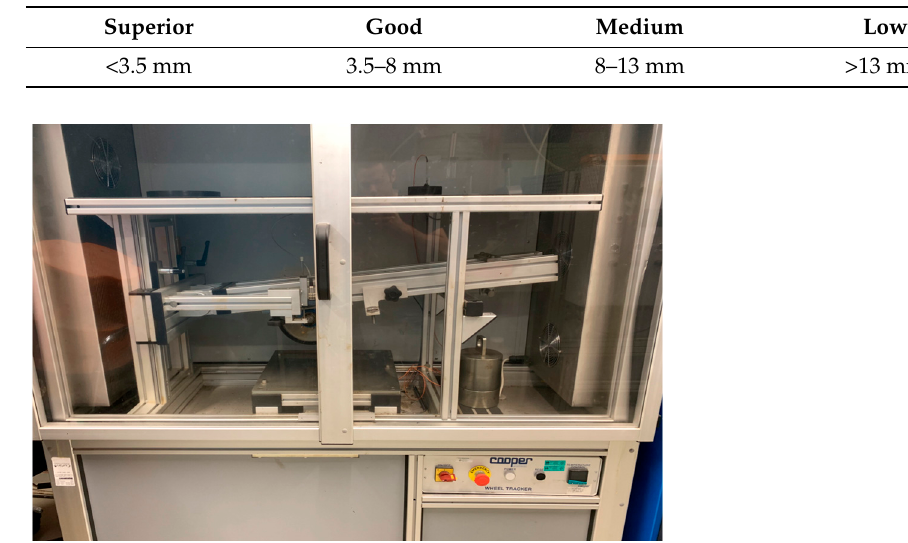
Table 5. Mixed performance criteria (AGPT-T231-6).